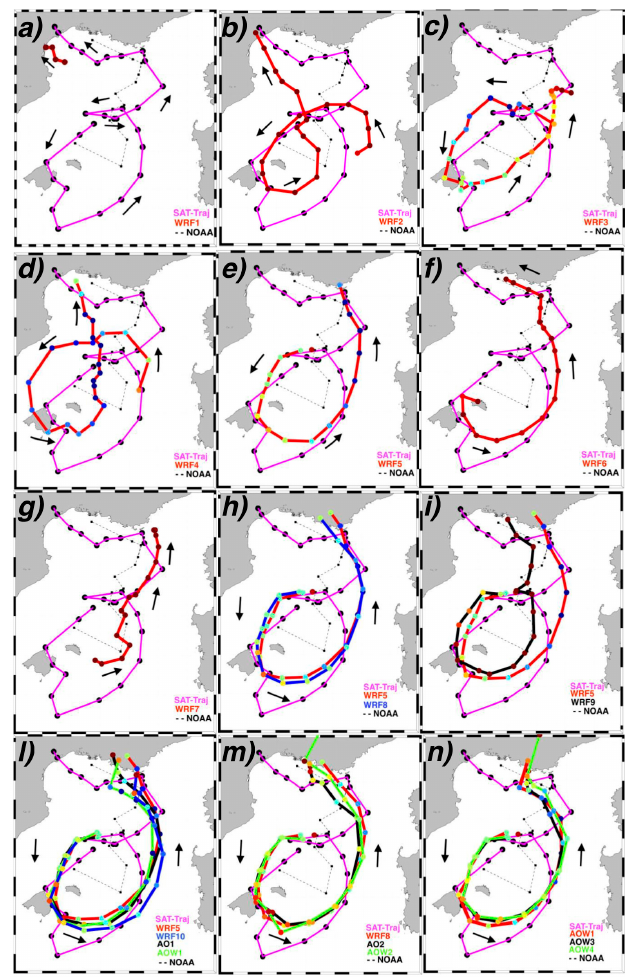
Figure 7. Trajectory and intensity of the cyclone for all simulations. In purple the trajectory estimated using observations from geo-referenced satellite image, which starts at 00:00 UTC, 6 November 2011, and ends at 12:00 UTC, 9 November 2011. The trajectory identifies the minimum pressure of ROLF every 3 h. Values of pressure minimum are highlighted by the color of the dots. The black arrows show the direction of propagation of the Medicane. In the different panels we can observe the trajectories resulting from the various runs, compared with the trajectory obtained from the satellite, and the trajectory proposed by the NOAA. Panels ( a – g ): runs WRF1-7 (atmosphere standalone). Panel ( h ): runs WRF5 and WRF8 (MYJ and MYNN PBL). Panel ( i ): runs WRF5 (with MYJ) and WRF9 (WRF with SST decreased by 3 ◦ C). Panel ( l ): runs WRF5, WRF10 (with high resolution SST from MFS-system), AO1 and AOW1 (AO and AOW with MYJ PBL scheme). Panel ( m ): runs WRF8, AO2 and AOW2, using MYNN PBL scheme. Panel ( n ): runs AOW1, AOW3, AOW4 using the different surface roughness schemes (OOST, TY,